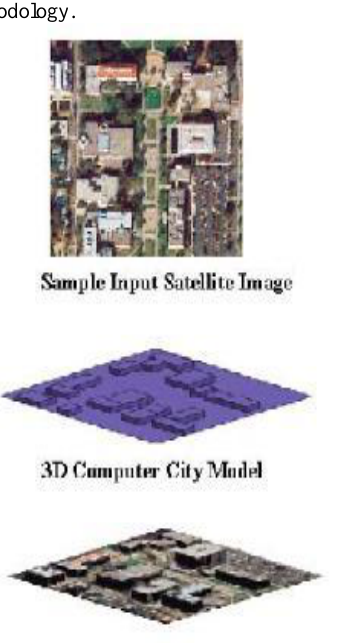
Fig.17. Output Image of 3D Computer City (Source- Kobayashi and